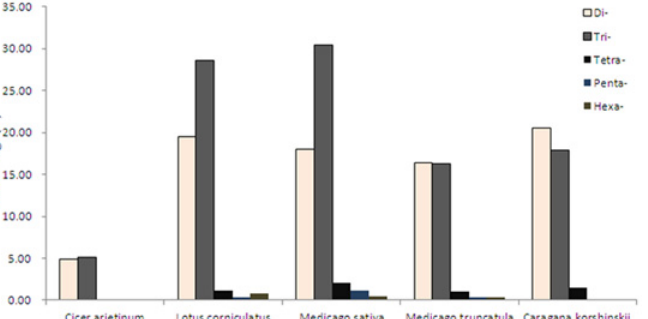
Fig 3. SSRs motif distribution analysis in Caragana korshinskii Kom . and 4 supplementary materials from public database. The bars from left to right in each species represent di-, tri-, tetra-, penta- and hexa- nucleotides.